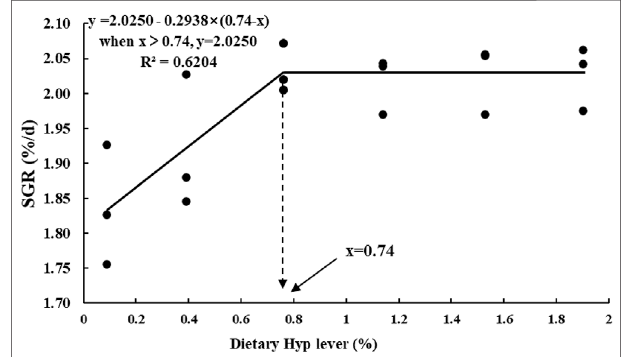
FIGURE 1 | Broken-line regression analysis between SGR and dietary Hyp level in ITCC fed with different experimental diets for 8 weeks. The breakpoint of the broken-line is 0.74% of dry